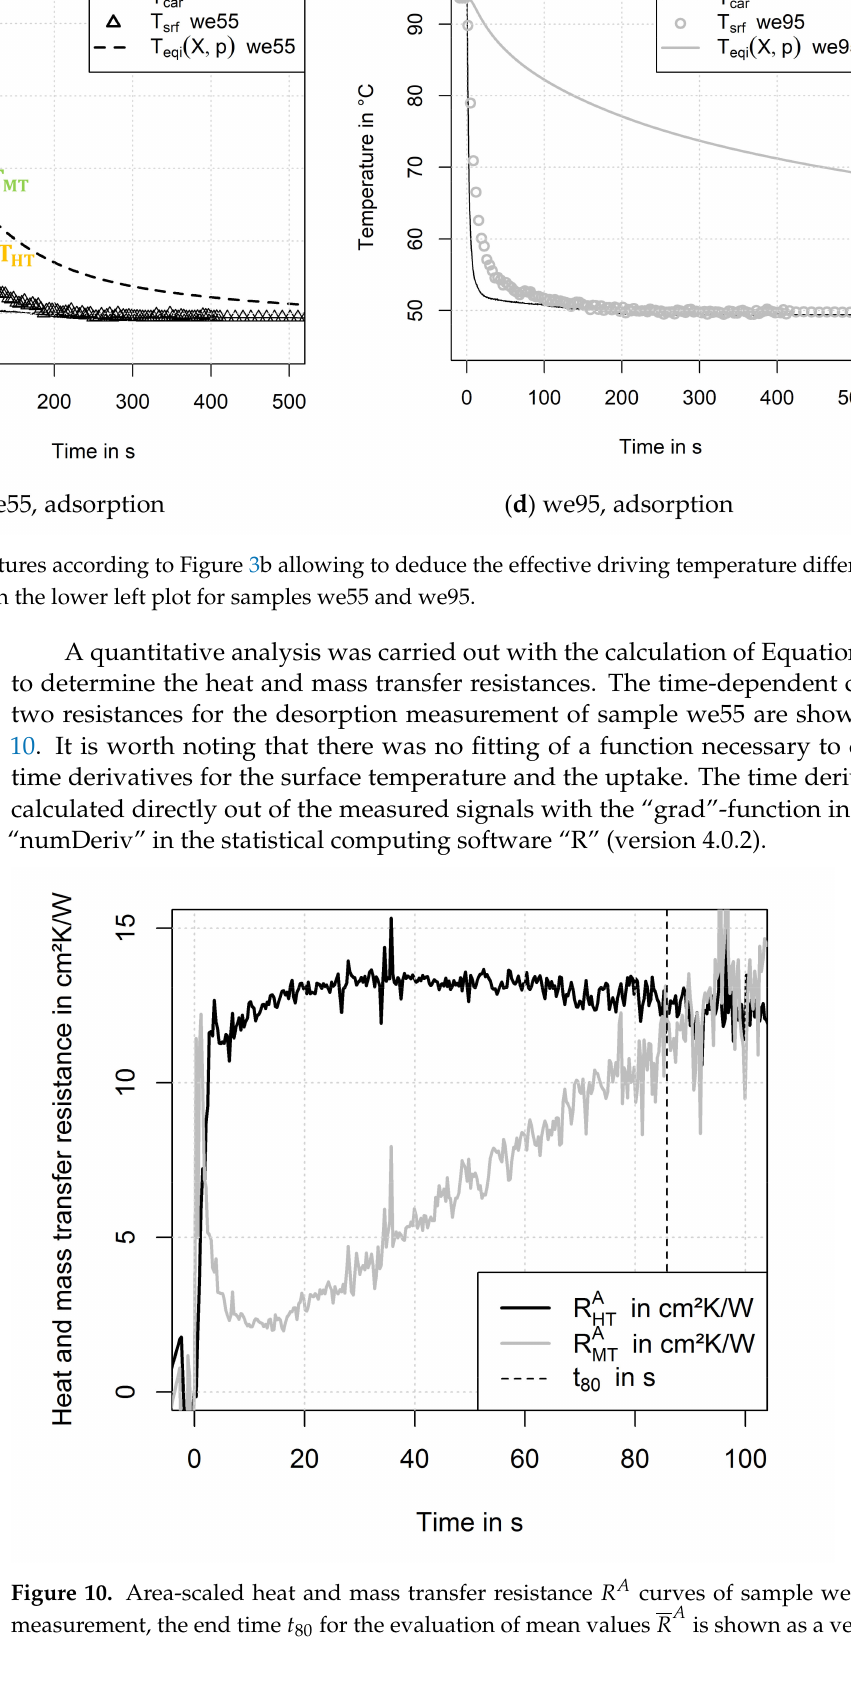
A is shown as a vertical